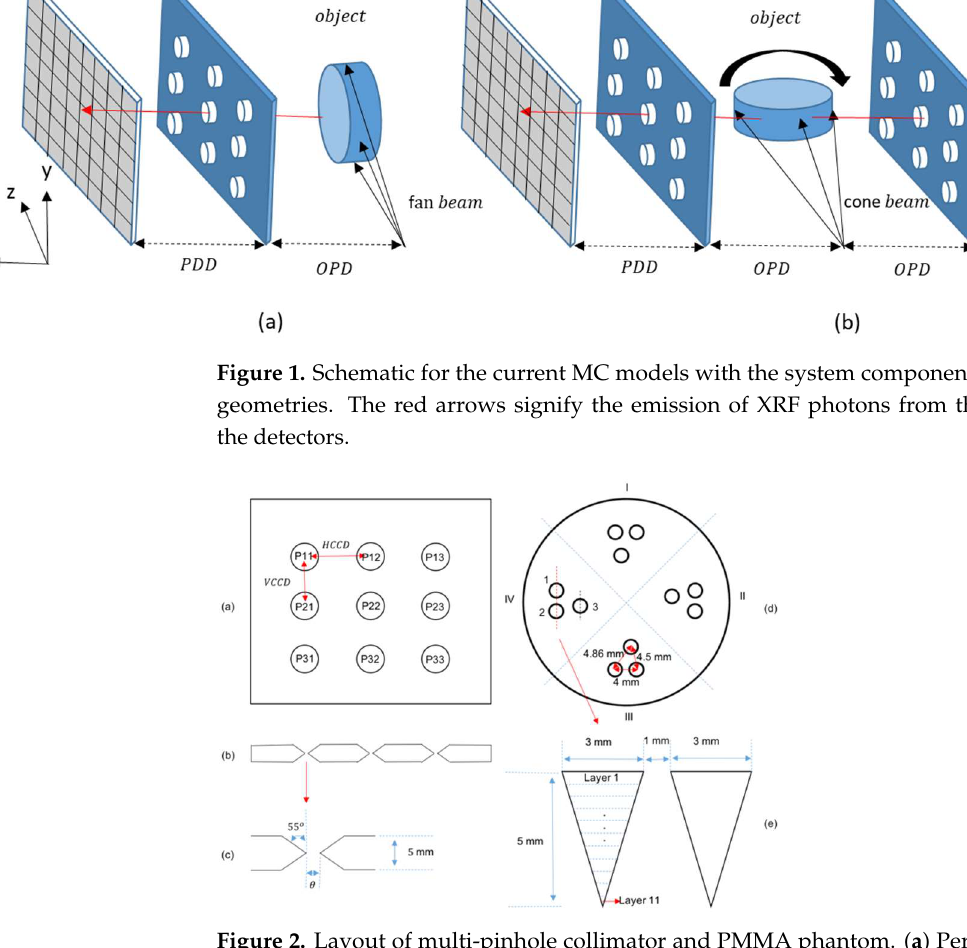
Figure 2. Layout of multi-pinhole collimator and PMMA phantom. ( a ) Perpendicular view of the lead plate containing nine pinholes; ( b ) cross-section of the lead plate containing the centers of the pinholes; ( c ) cross-section of a pinhole; ( d ) phantom and ( e ) vertical section of the phantom along the red dashed line.